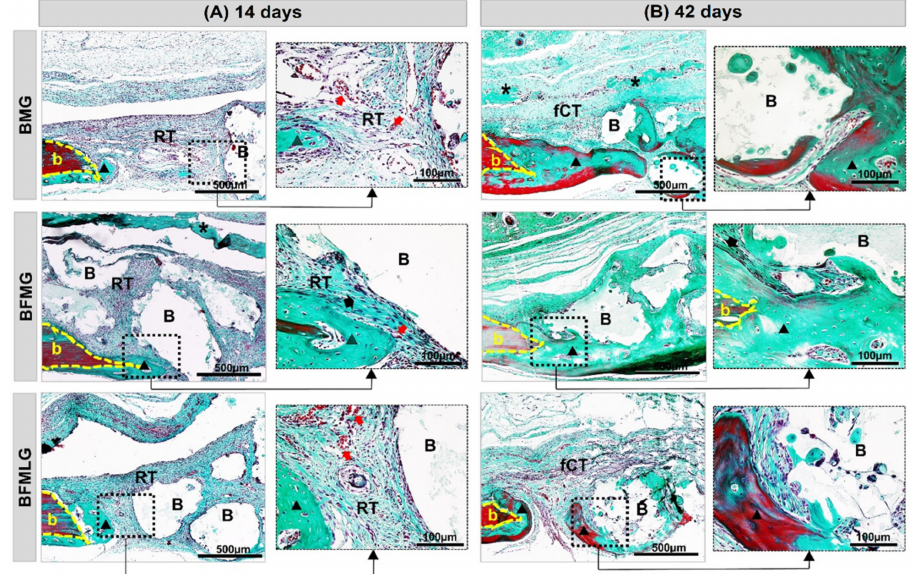
Figure 3. ( A , B ) Histological images of the evolution of defects in rat calvaria in the experimental periods of 14 and 42 days, respectively. BMG—defects filled with HA/ β -TCP covered by a bovine biological membrane; BFMG defects filled with HA/ β -TCP and heterologous fibrin biopolymer covered with bovine biological membrane; BFMLG defects filled with HA/ β -TCP and heterologous fibrin biopolymer covered with bovine biological membrane and PBMT. Bone border (b), reactive connective tissue (RT), biomaterial particles (B), bovine biological membrane (asterisk), new bone tissue (black triangle), fibrous connective tissue (TCf), collagen fibers (black arrow), blood vessel cells (red arrow). Masson’s trichrome. Original 10 × magnification; bar = 500 µ m and inserts, 40 × enlarged images; bar = 100 µ